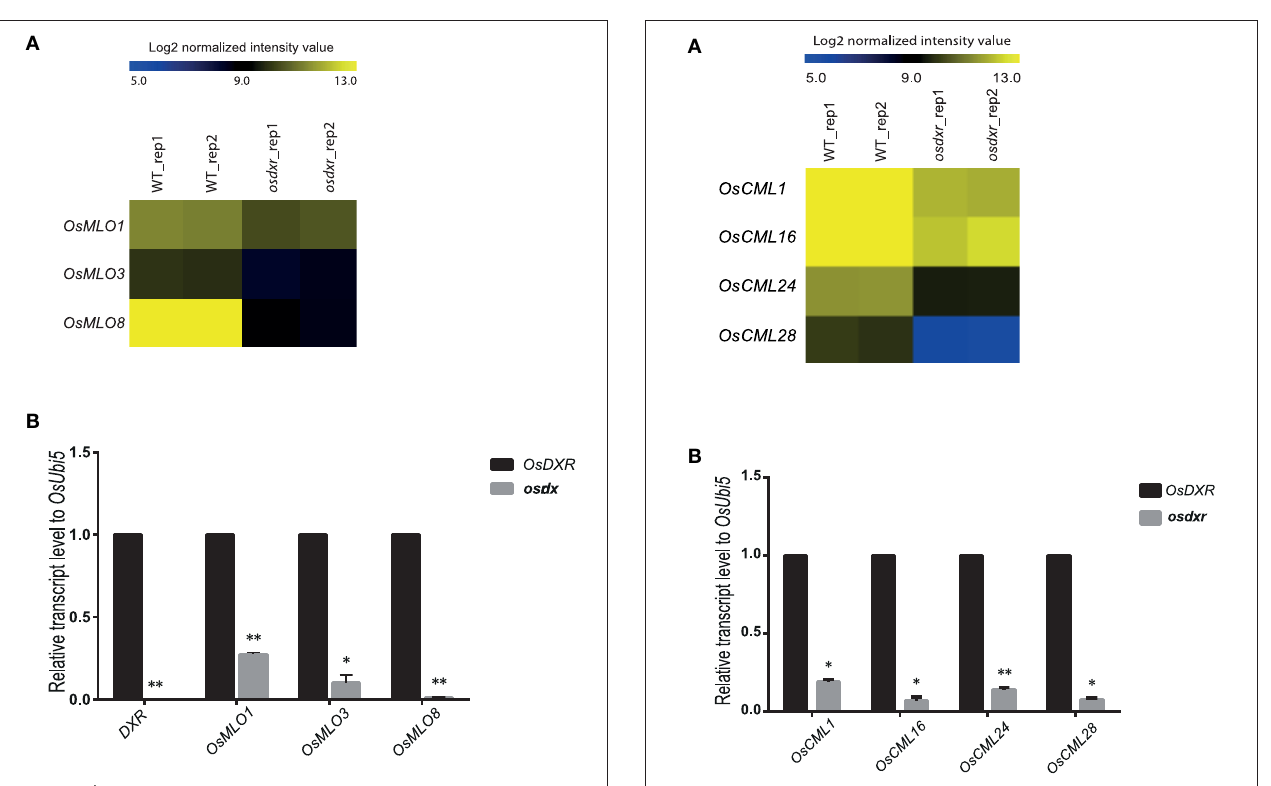
FIGURE 6 | Heatmap for expression patterns of OsCML genes in wild-type (WT/DXR) rice and osdxr mutant. (A) Expression analysis of 4 OsCML genes using Agilent 60K microarray data for WT vs. osdxr knockout line. (B) Downregulation of OsCML genes in osdxr mutant demonstrated by real-time PCR analysis. ** p < 0.01; *0.01 < p <